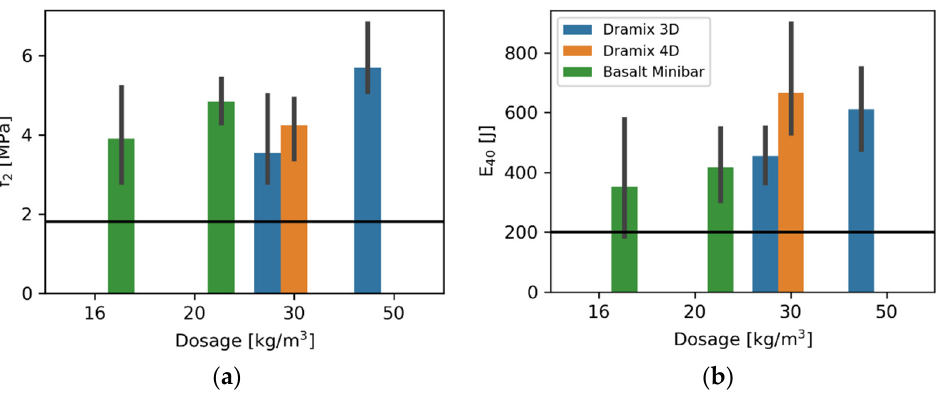
Figure 7. Residual flexural strength at 2 mm deflection for required dosages of fibres to fulfil f (cid:2928)(cid:2915)(cid:2903)(cid:2907)(cid:2889) ( a ) and energy absorption at 40 mm deflection for required dosages to fulfil f (cid:2928)(cid:2915)(cid:2885)(cid:2905)(cid:2903) ( b ) in rock with good quality, i.e., Q = 20. Horizontal line indicates the f (cid:2928)(cid:2915)(cid:2870) limit for TPL design ( a ) and the E (cid:2872)(cid:2868) limit for a design based on the Q-method ( b ).